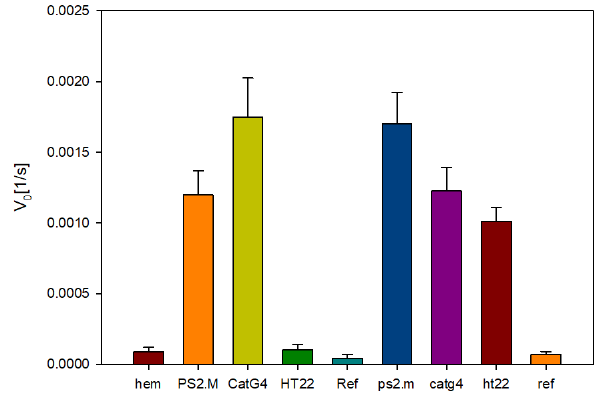
Figure 4: Activity of DNAzymes and 2’-OMe-ribozymes in the oxidation reaction of ABTS in the presence of K + . Conditions: 10 mM Tris-HCl (pH=8.0), 100 mM KCl, 0,0016% Trition X-100, 0.5 µM DNA/2’OMeRNA, 0.5 µM hemin, 1 mM ABTS, 1 mM H